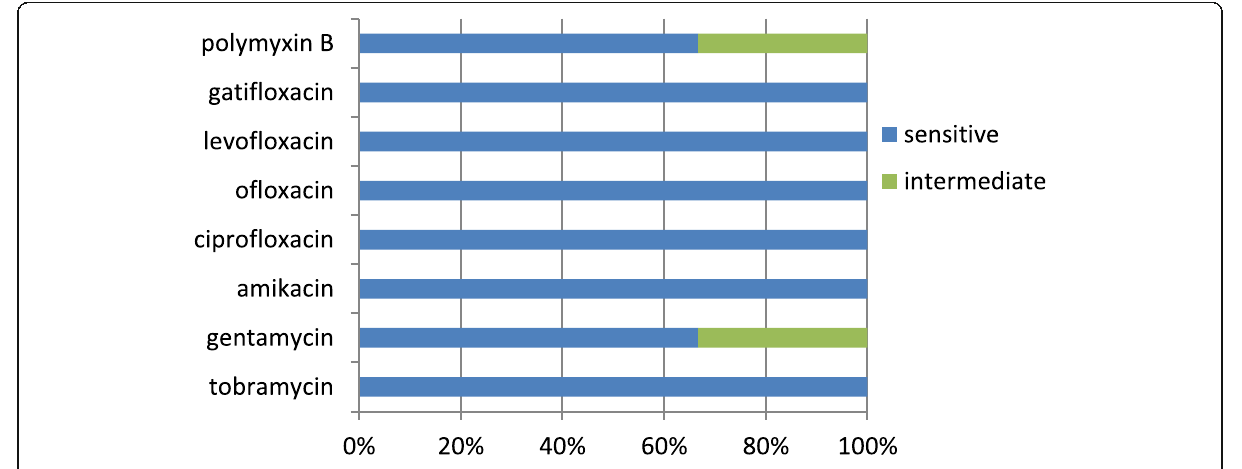
Fig. 4 Antibiotic susceptibility pattern of Pseudomonas by disk diffusion method